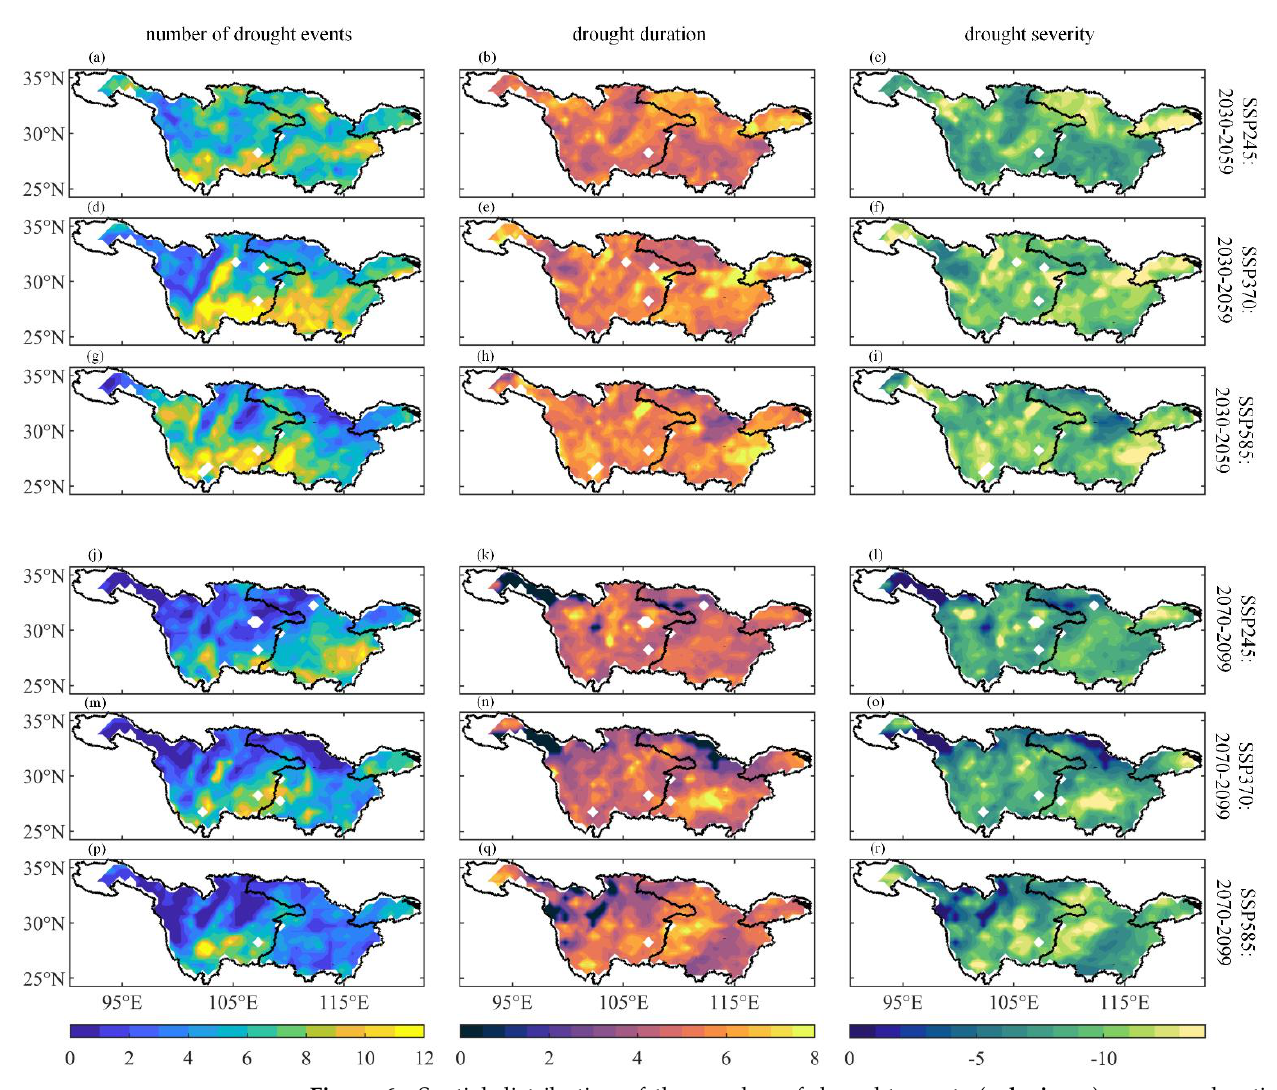
Figure 6. Spatial distribution of the number of drought events ( a , d , g , j , m , p ), average duration ( b , e , h , k , n , q ), and average severity ( c , f , i , l , o , r ) in the 6-month scale in the Yangtze River basin from 2030–2059 ( a – i ) and 2070–2099 ( j – r ) under the three scenarios of SSP245 ( a – c , j – l ), SSP370 ( d – f , m – o ), and SSP585 ( g – i , p – r